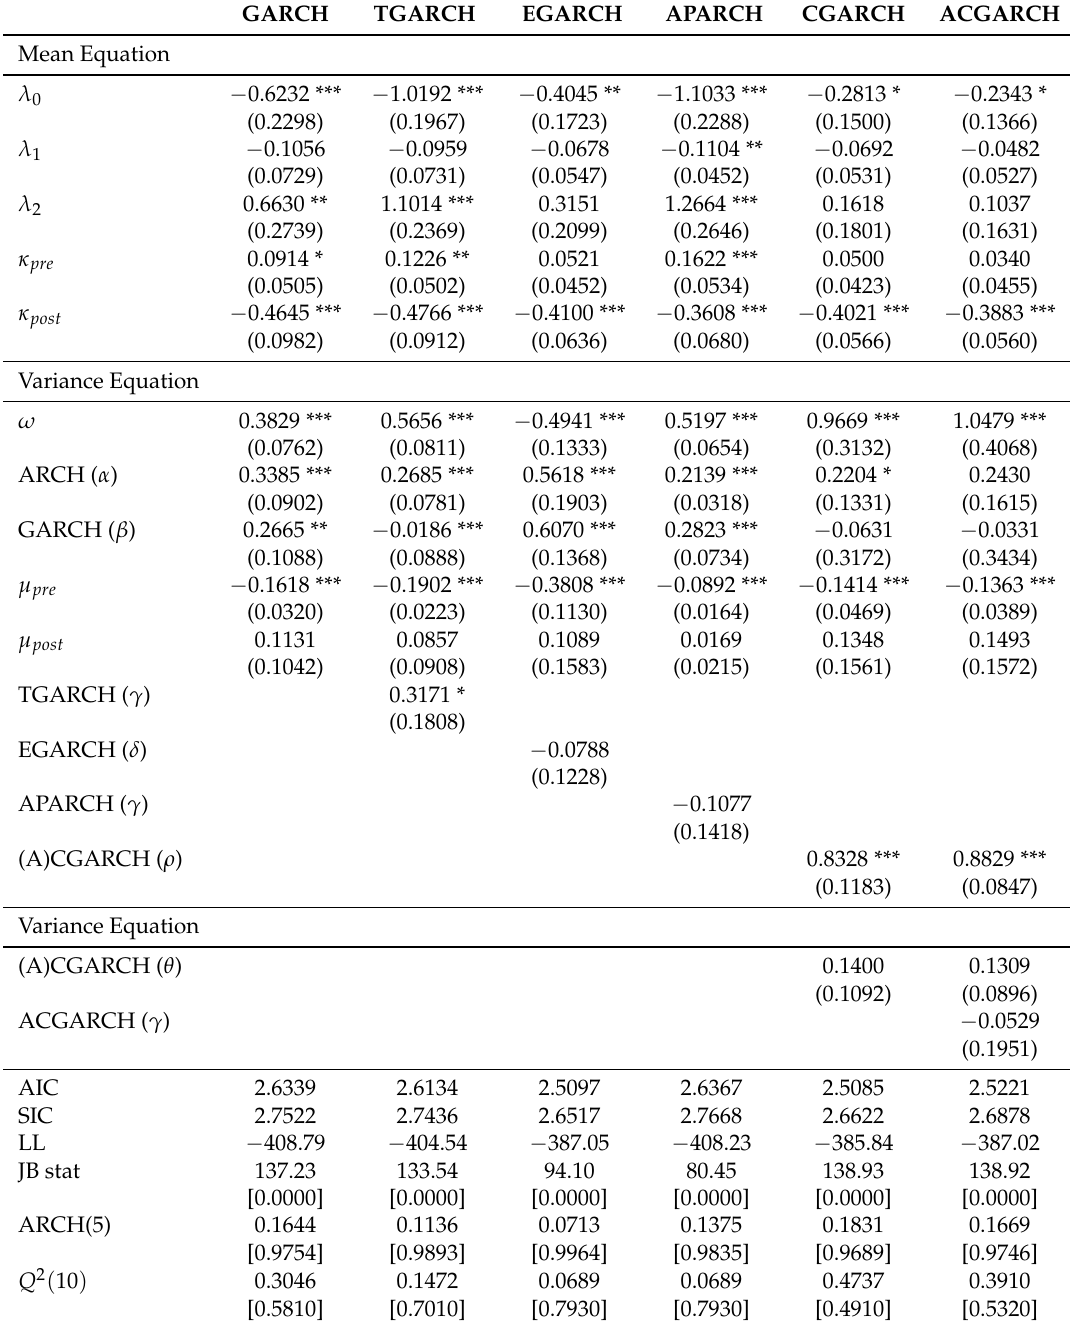
Table A7. GARCH-M Tests for Bitcoin Cash for the sample of 360